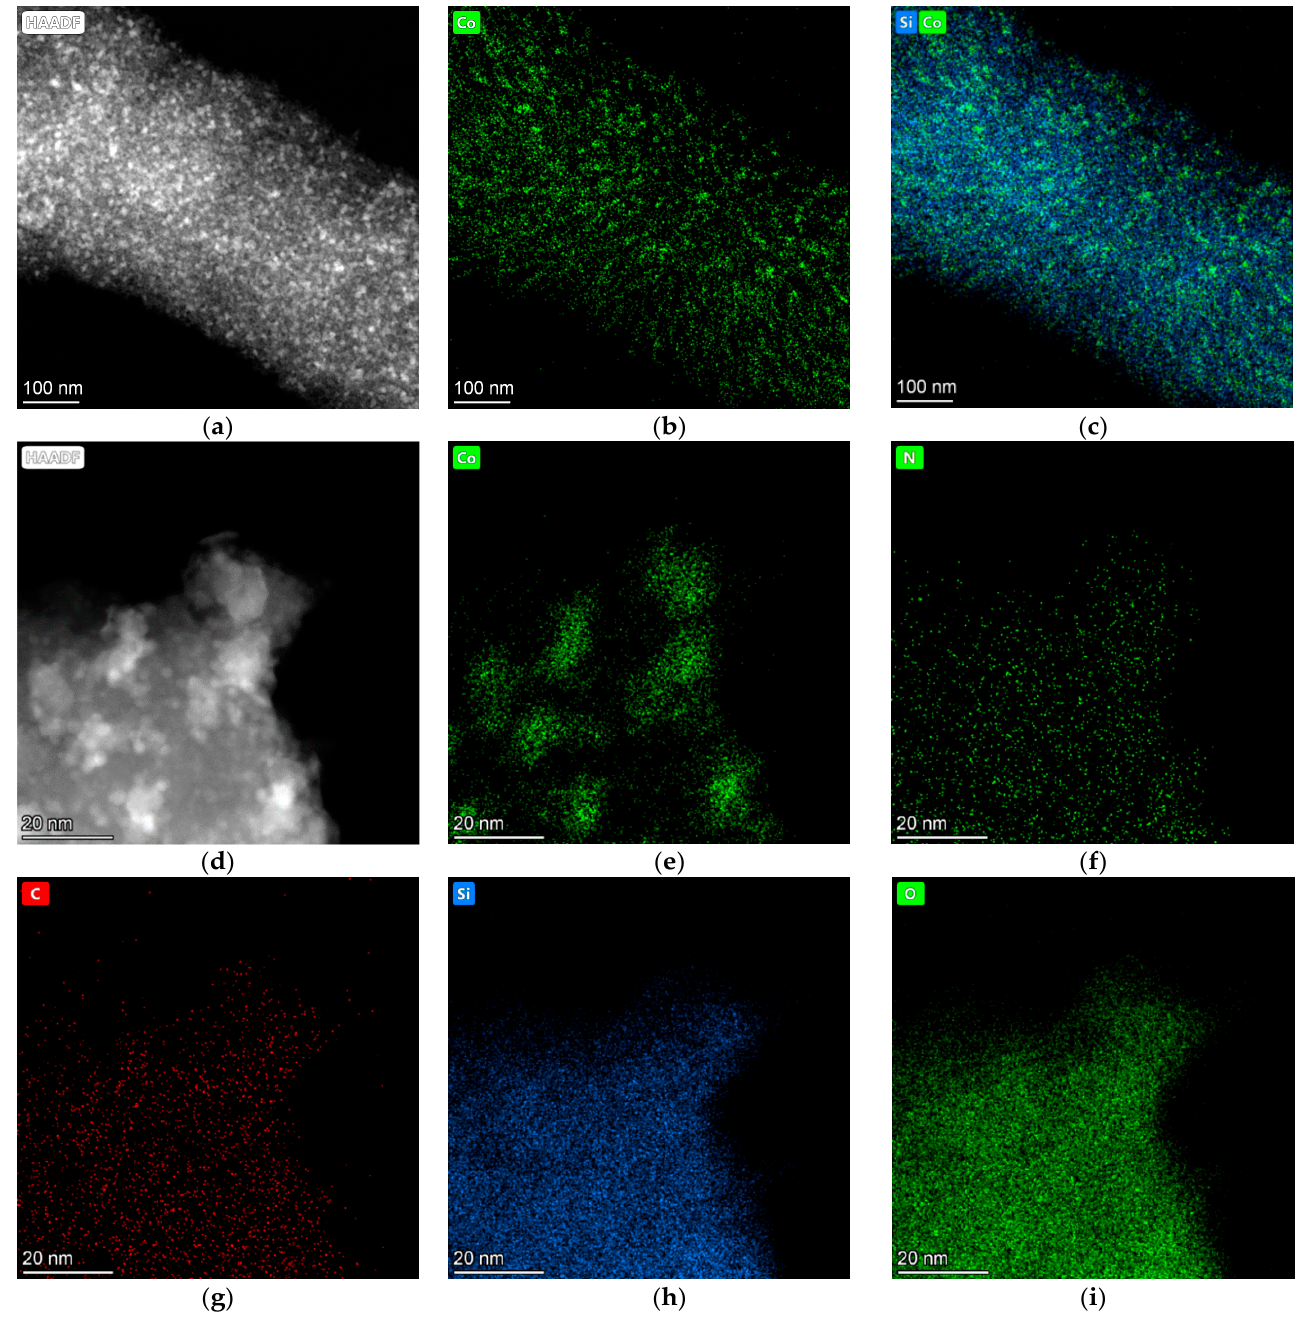
Figure 10. ( a , d ) HAADF and related ( b , c , e – i ) EDX-STEM elemental mapping images of Co-N-C/SiO 2